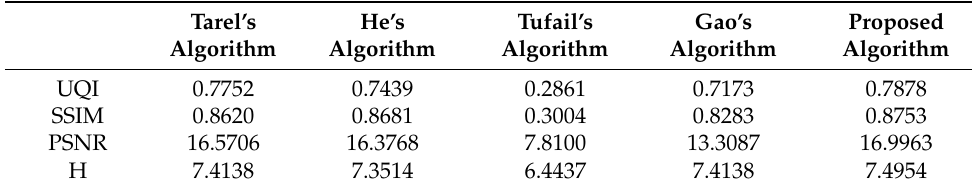
Table 4. Objective evaluation results on the fourth group of defogged images based on five defogging